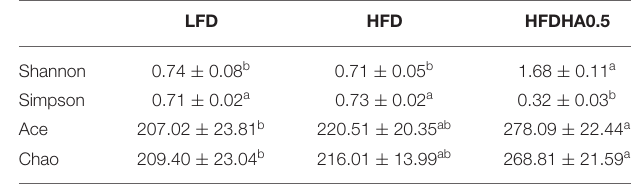
TABLE 6 | The predominant gut bacterial genus in zebrafish fed the LFD, HFD, or HFDHA 0.5 for 2 weeks based on V3–V4 sequences. Genus (%) LFD HFD HFDHA0.5